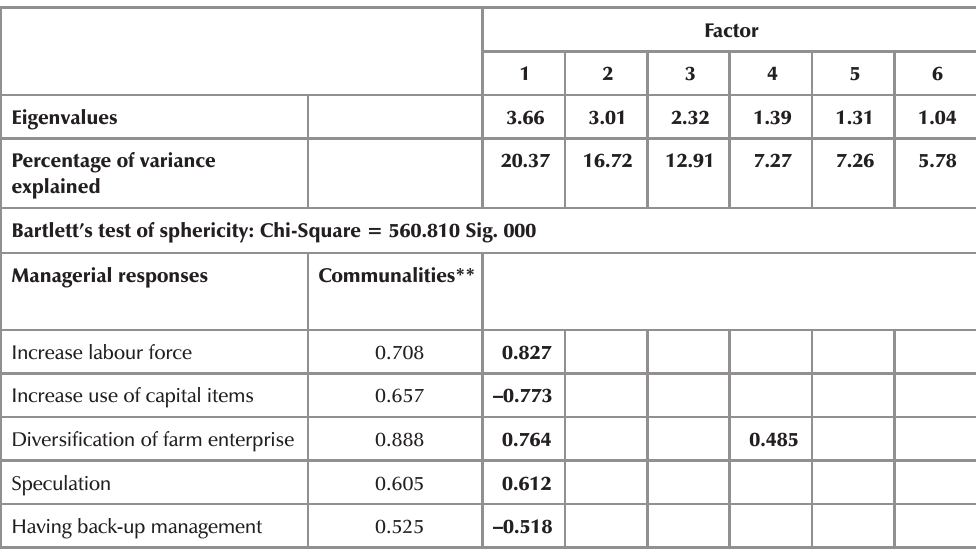
Rotated factor loadings* and factor scores of managerial responses to risk for sample commercial dairy farmers in the three zobatat of Eritrea, 2002/03